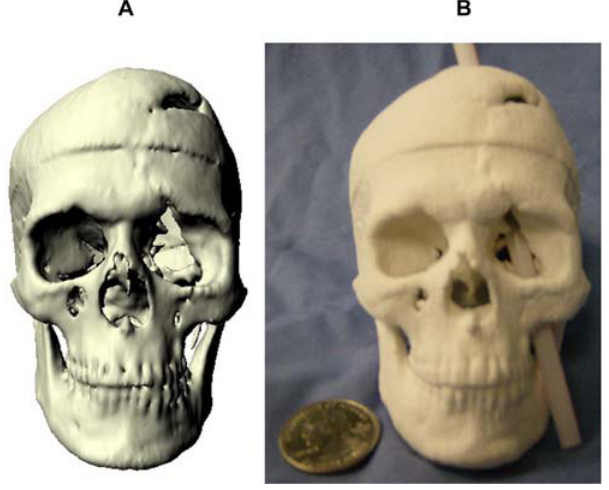
Figure 4. Stereolithograph of Phineas Gage’s Skull. The processing pathway we developed can replicate preserved specimens. (a) Virtual model of Phineas Gage’s skull. (b) With this physical 3D model of Phineas Gage’s skull, we illustrate the approximate path of the tamping iron that produced Phineas Gage’s famous injury.